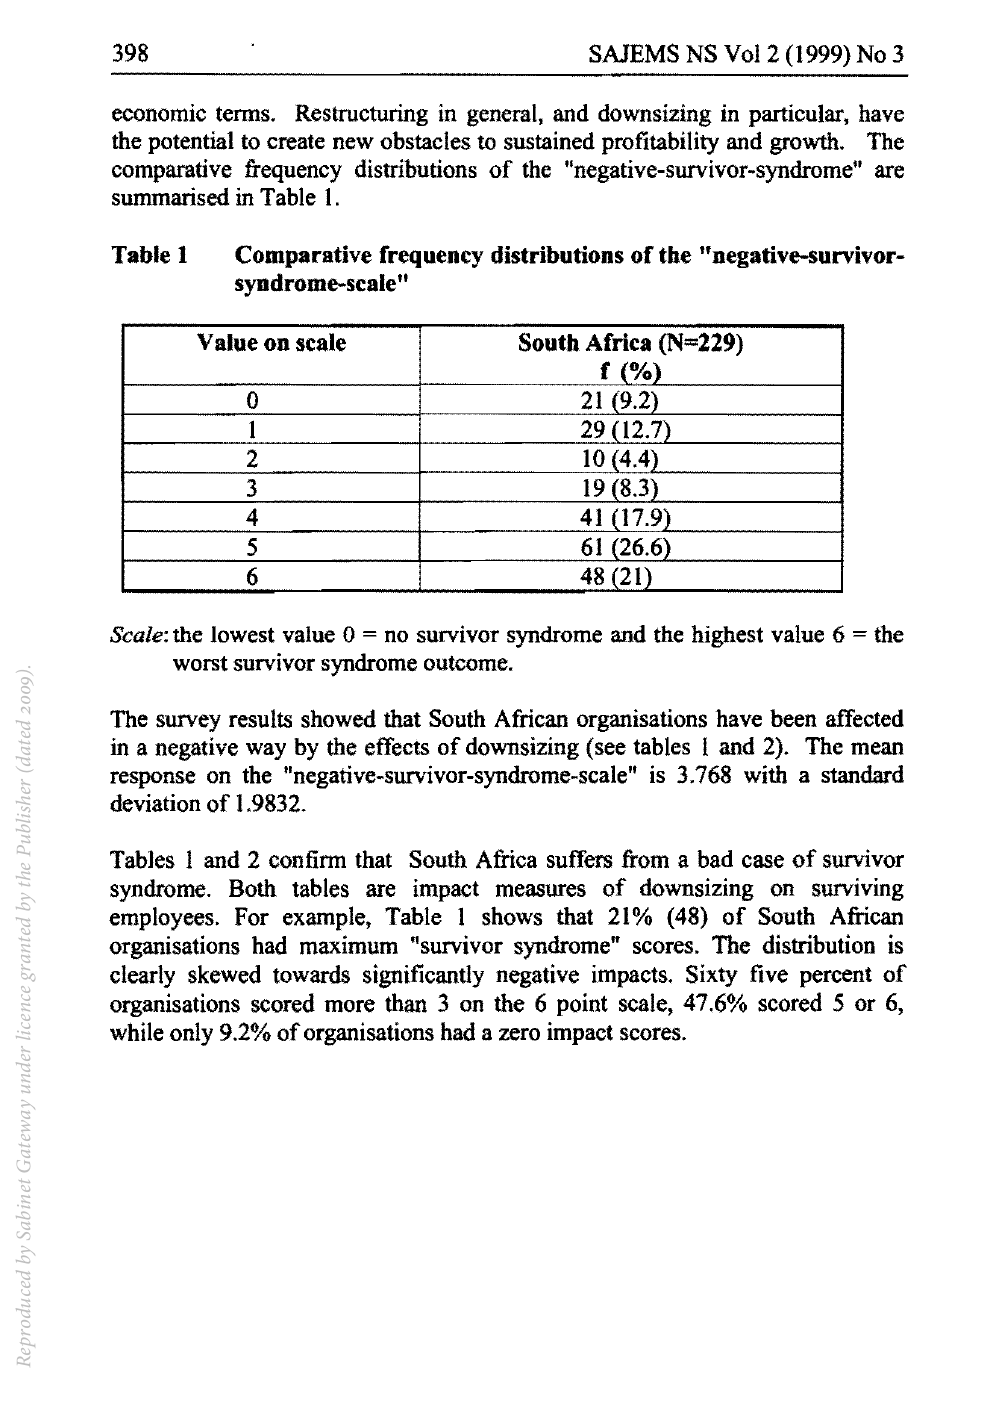
Comparative frequency distributions of the "negative-survivor syndrome-scale"